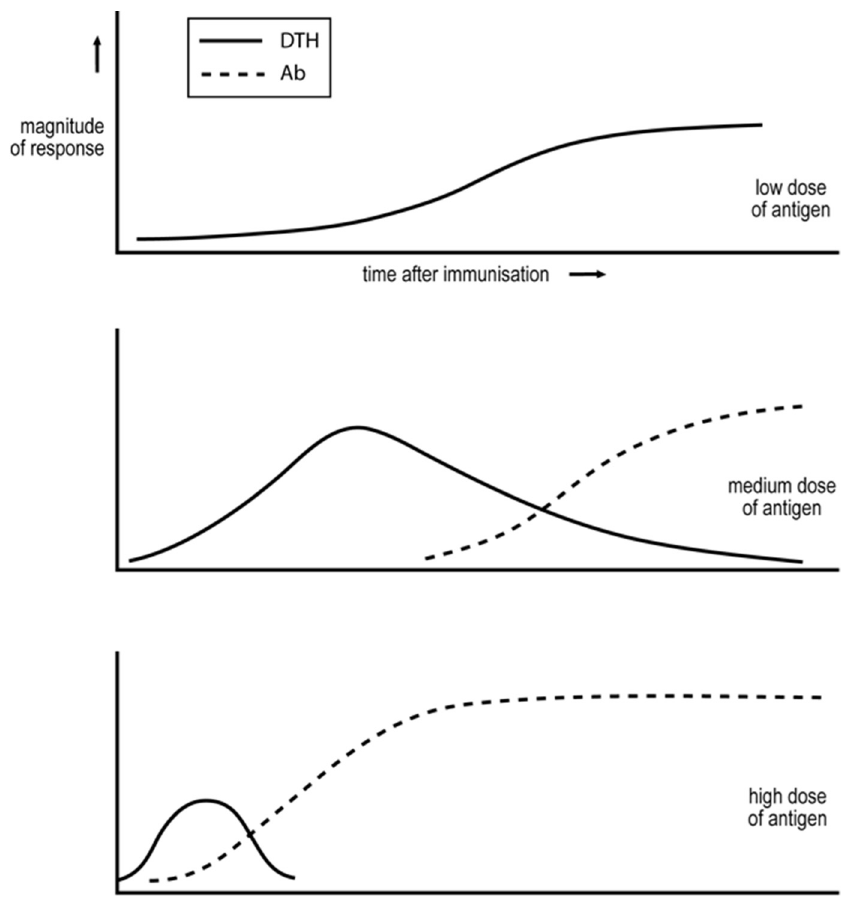
Figure 1. Encapsulation of Salvin’s findings [14].